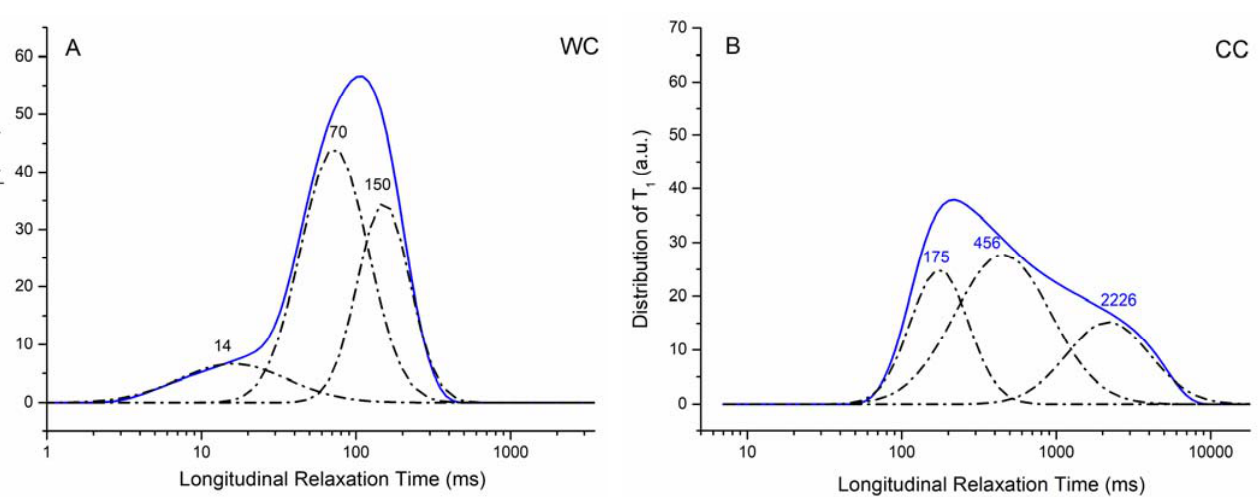
Figure 6. Relaxograms (i.e., distribution of longitudinal relaxation times) for the WC ( A ) and CC ( B ) biochar samples.